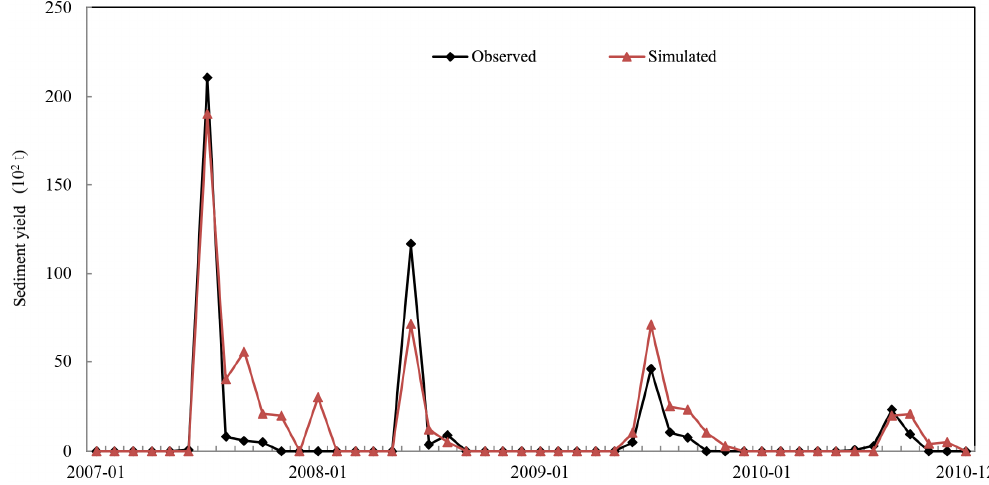
Figure 7. Comparison between the simulated and observed monthly runoff in model validation.